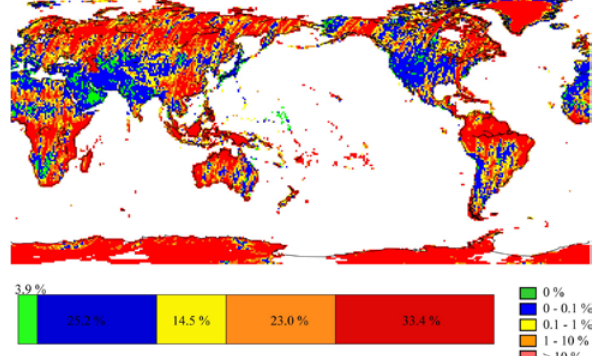
Figure 1. Tile based bad pixel rate distribution and statistics of ASTER GDEM version 1 except for